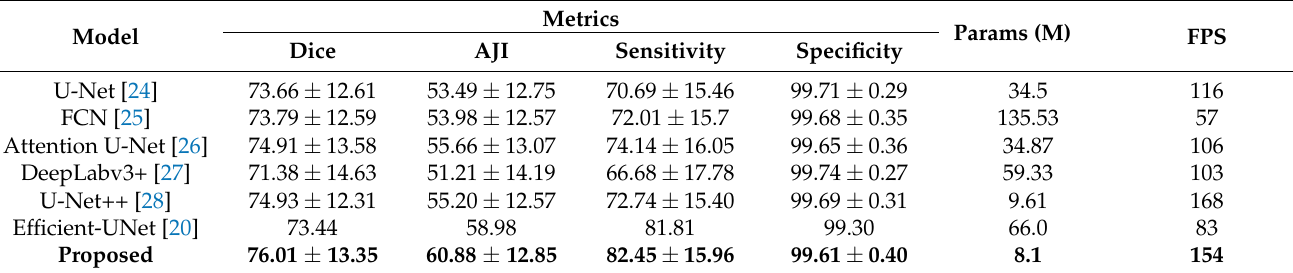
Table 3. Segmentation results (mean ± standard deviation) of the proposed model compared with six state-of-the-art methods. The best results are highlighted in